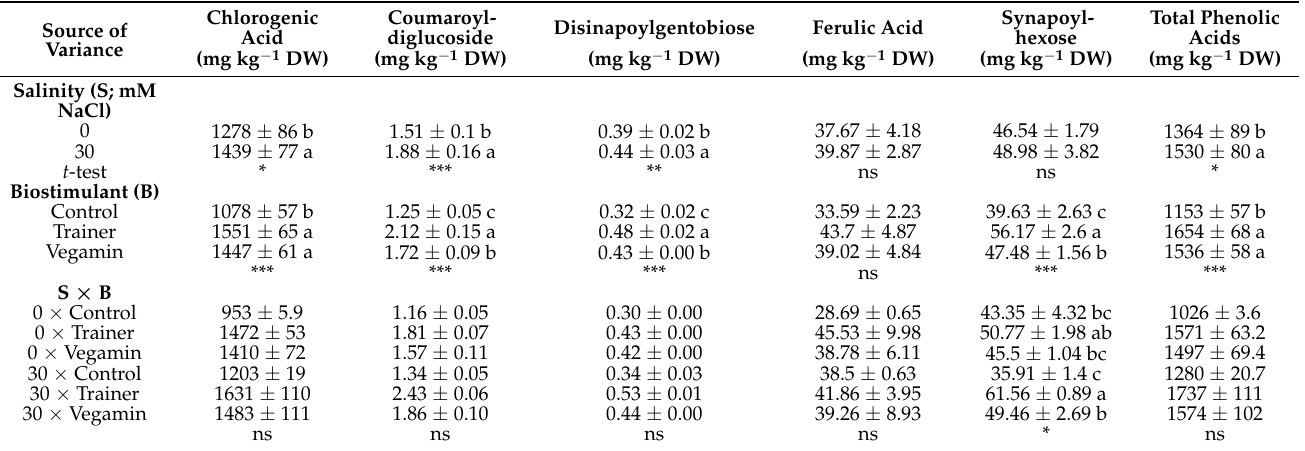
Table 5. The modulation of the leaf content of phenolic acids as affected by salinity and biostimu- lant